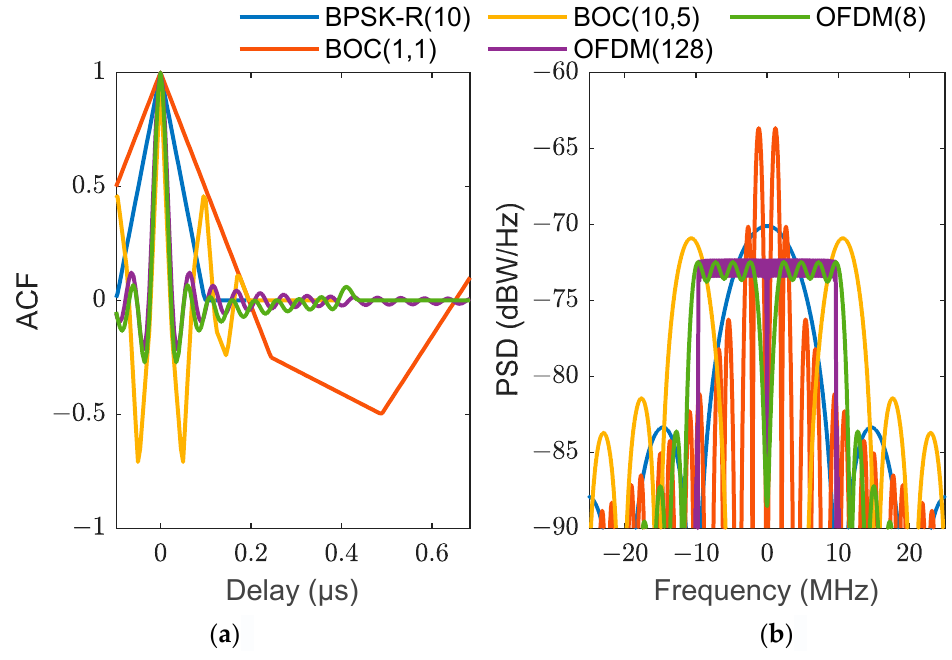
Figure 9. Comparison between the navigation signal and traditional signal. ( a ) ACF; ( b ) PSD.